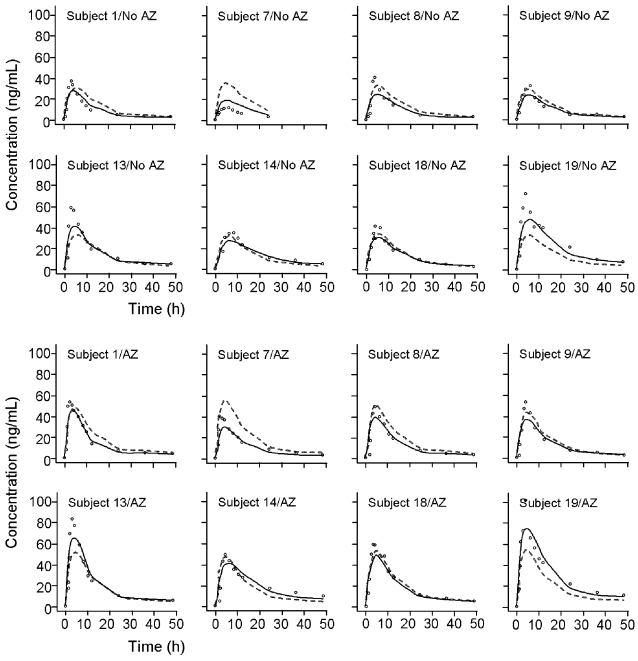
Observed, population predicted, and individual predicted ivermectin concentrations of individual subjects following ivermectin alone (No AZ) and after co-administration with azithromycin (AZ) for Subpopulation B, where increased bioavailability is observed in the interaction period.The solid line represents the fit predicted by the typical pharmacokinetic mixture model parameters. The dashed line shows the fit of the post hoc estimates of the population model. Circles represent the observed concentrations.